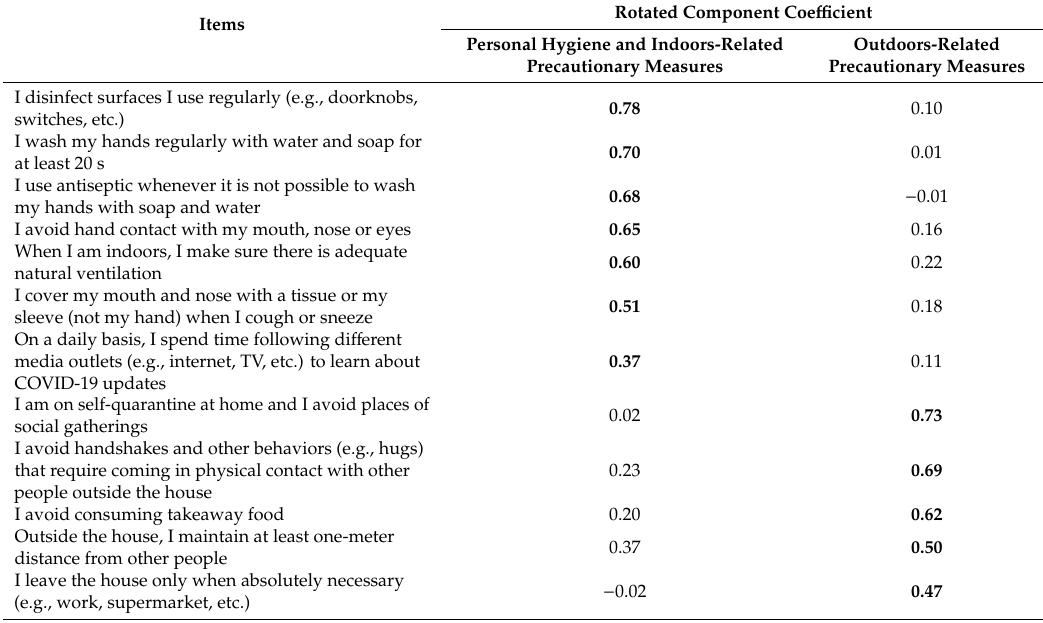
Table 4. Rotated Structure Matrix for PCA with Varimax rotation of a two Component